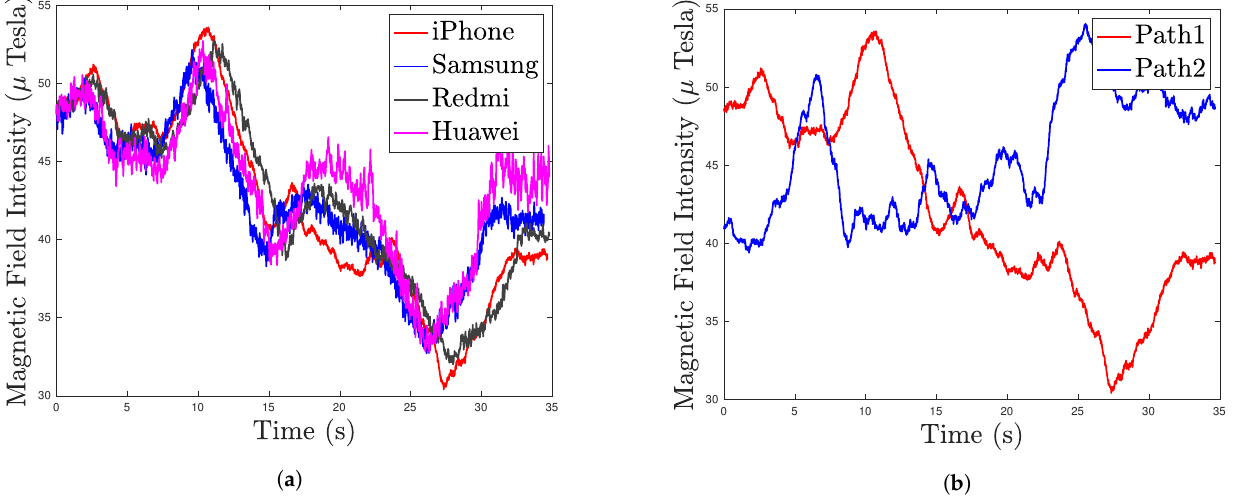
Figure 4. Trajectory test: ( a ) Comparison of MF measurements of heterogeneous smartphones in the